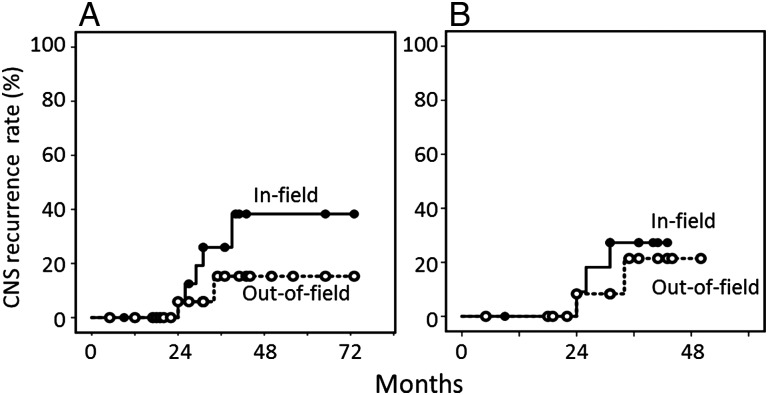
In-field and out-of-field CNS recurrence curves for 24 patients undergoing PBRT (A) and 16 patients undergoing PBRT plus MTX-based chemotherapy (B).